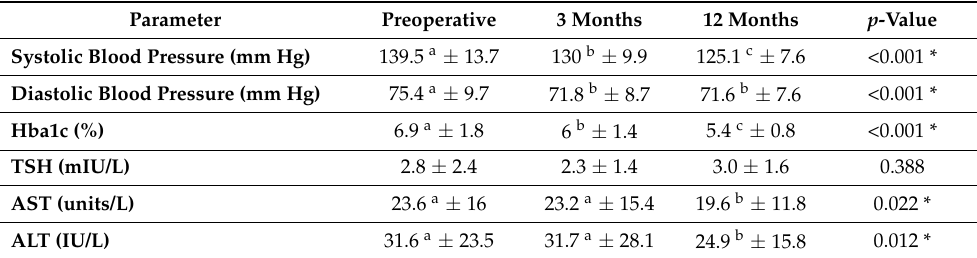
Table 1. Comparison of blood pressure and biomarkers related to obesity across a 12-month period postoperatively (n = 160).